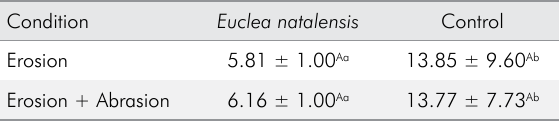
Table 2. Wear (µm) of dentin (mean ± SD), with or without application of the gel, under two experimental